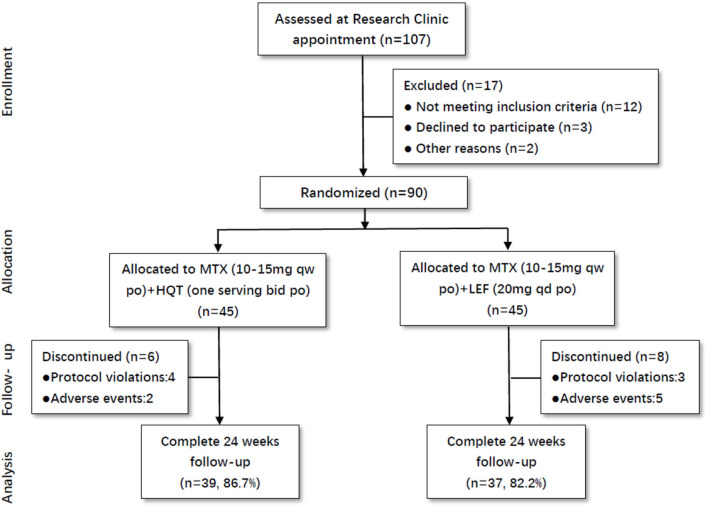
Participant flow through the trial.